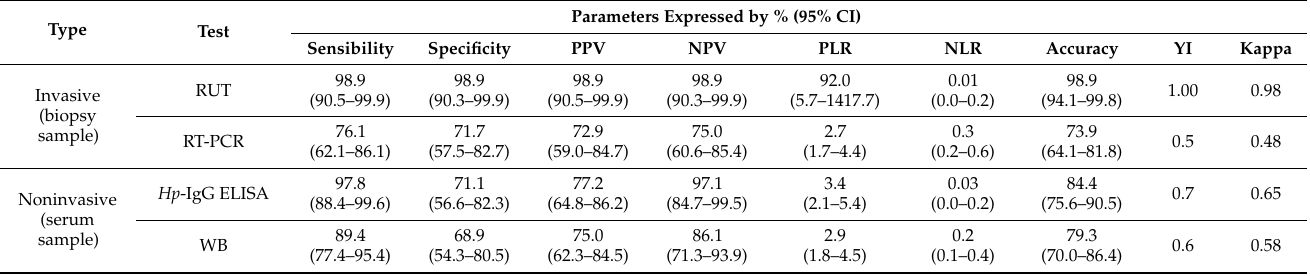
Table 3. Precision indicators of diagnostic tests for detecting H. pylori in adult Primary Healthcare patients with the gastroduodenal disease compared to H. pylori status